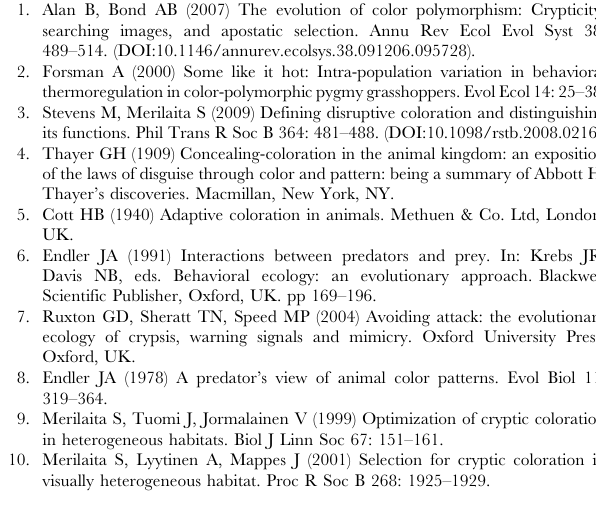
Table S1 The number of photographs used in the detection task experiment for each human predator.